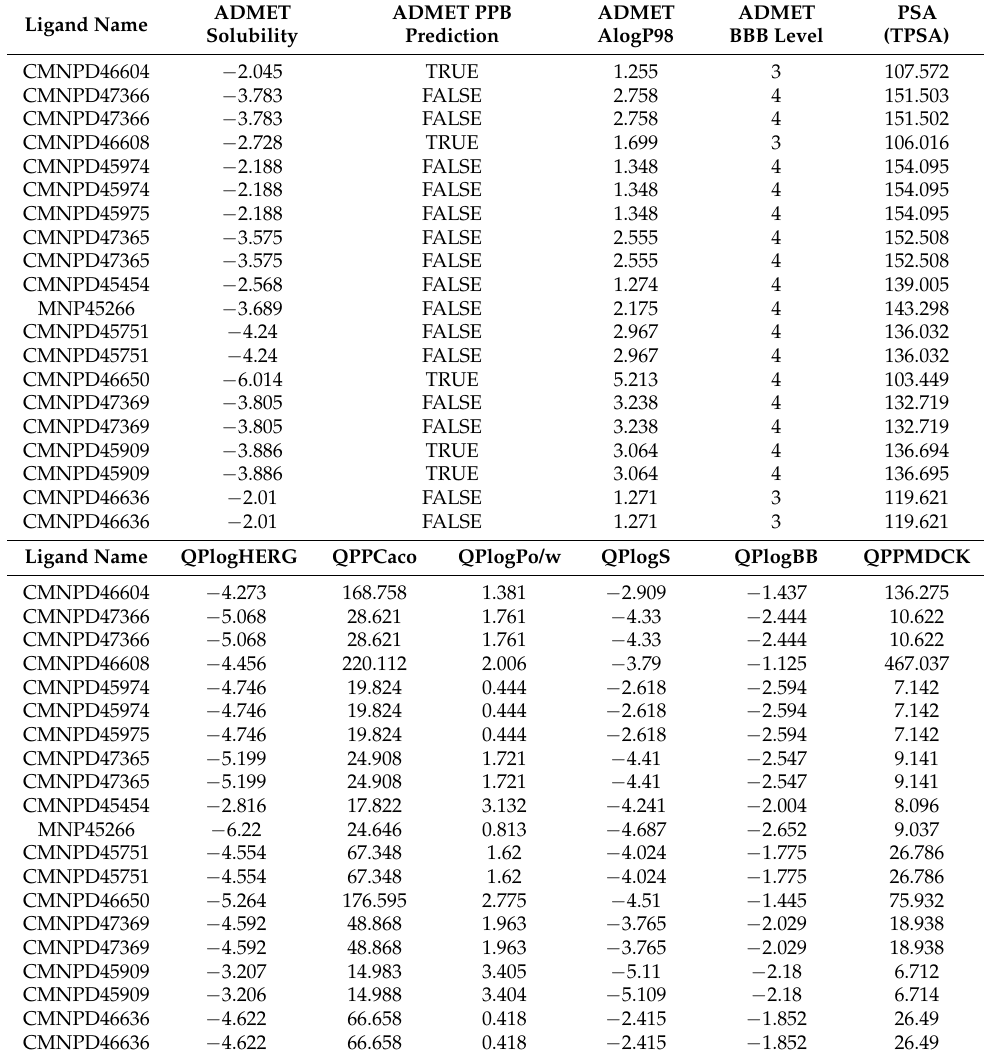
Table 2. ADME properties of the top twenty compounds in similarity